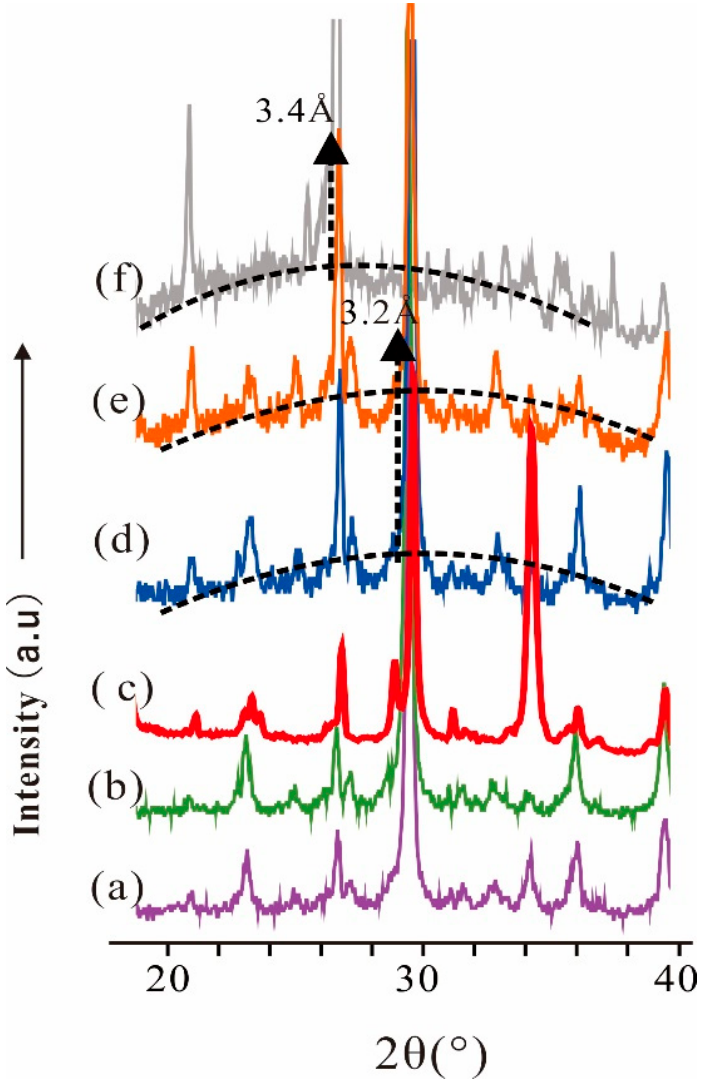
Figure 4. The XRD patterns of FA and FA/CCR-based geopolymers enlarged at 20° (2 θ ) to 40° (2 θ ). ( a ) FA1CCR2-0.4-80 °C; ( b ) FA1CCR2-0.4-50 °C; ( c ) FA1CCR2-0.6-50 °C; ( d ) FA1CCR1-0.4-50 °C; ( e ) FA2CCR1-0.4-50 °C; ( f ) FA.